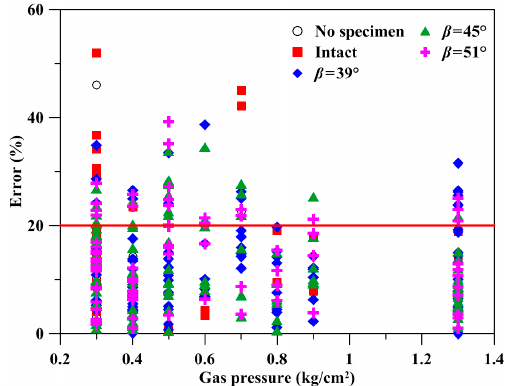
Figure 4. Average error ( e ε ) in early dynamic equilibrium state for all SHPB tests in this study. 210 of 311 specimens have e ε < 20%. Plot of e ε with gas pressure. Table 1. Illustration of red patches on pressure measurement films (PMFs) used between interfaces of embedded specimen and incident and transmitted bars in a SHPB test. Medium-pressure types are used except low-pressure type is used in the four on the right of the last row, with gray background.